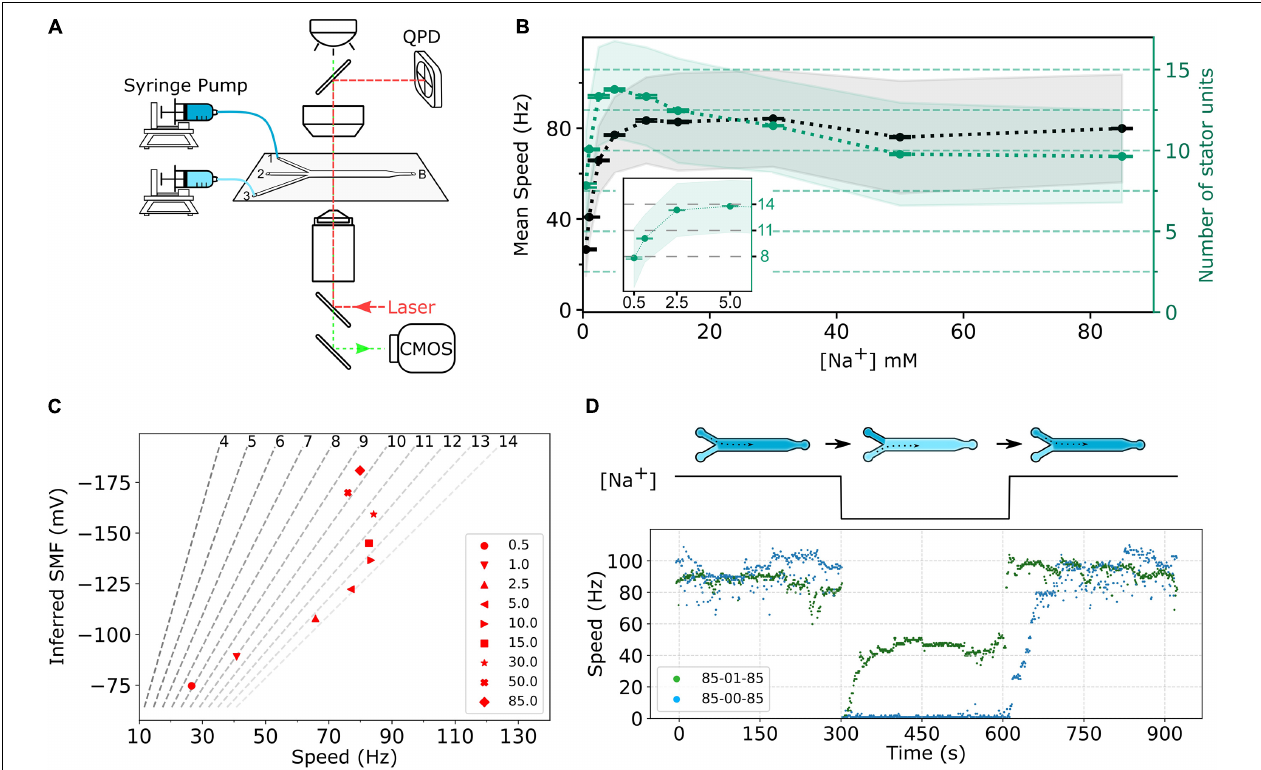
FIGURE 2 | (A) Schematic of the experimental setup. The bacterial cells are immobilized on the surface of a three-way microfluidic chamber. The BFMs’ rotations were recorded by a high-speed CMOS camera (green light path), and one BFM rotation can be measured simultaneously by a BFI system (red light path). Two syringe pumps connect to inlet ports 1 and 3, respectively, to supply two different sodium concentrations of MB. Slow constant flow (20 µ L/min) is maintained all the time to remove any bacterial waste. (B) Sodium ion dependency of BFM speed. The black dots, gray shaded area, and error bar represent average BFM speed, the standard deviation, and the standard error of the mean, respectively, under the load of 1- µ m beads as [Na + ] ex varies. The green dots, light-green shaded area, and error bar show the inferred number of stator units, standard deviation, and standard error of the mean, respectively. Inset: Enlarge the number of stator unit data in the low-sodium region. The numbers of measured BFMs are N = 805, 2,463, 1,489, 1,785, 1,149, 1,929, 7,047, 2,562, and 6,833 for [Na + ] ex = 0.5, 1, 2.5, 5.0, 10.0, 15.0, 30.0, 50.0, and 85.0 mM, respectively. (C) BFM states diagram. The speed of BFM is dependent on the SMF and the number of stator units. The red dots are the BFM average speed in panel (B) and the SMF at that [Na + ] ex . The dashed lines are stator unit number contour line from Eq. 2 labeled at the top. (D) BFM speed response to the perfusion experiments. The top diagram shows the experimental course with X - Y - X mM [Na + ] ex perfusion. There are three stages in each experiment, and each stage remains approximately 5 min. The numbers in the legend indicate the [Na + ] ex at each stage. The bottom figure shows two represented experimental BFI data sets. For the 85-00-85 mM experiment (blue dots), the BFM speed drops to zero as [Na + ] ex was depleted and resurrected by stepwise speed increase as [Na + ] ex restored to 85 mM. For 85-01-85 mM experiments (green dots), the BFM speed drops to zero and then resurrected to a steady speed as [Na + ] ex changes to 1 mM. The speed returned back to high speed level as [Na + ] ex restored to 85